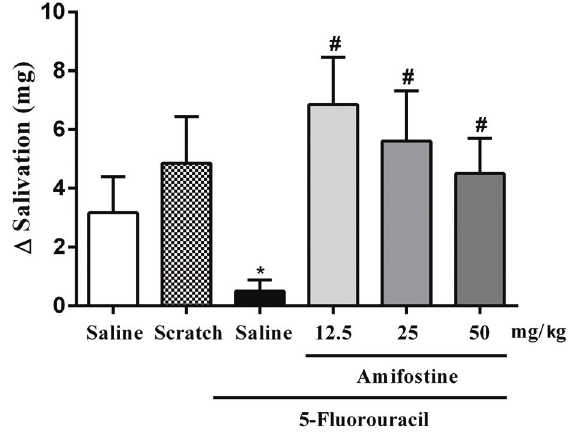
Figure 2. Amifostine improved 5- fl uorouracil (5-FU)-associated hyposalivation. Data are reported as means ± SE (n=6/group).